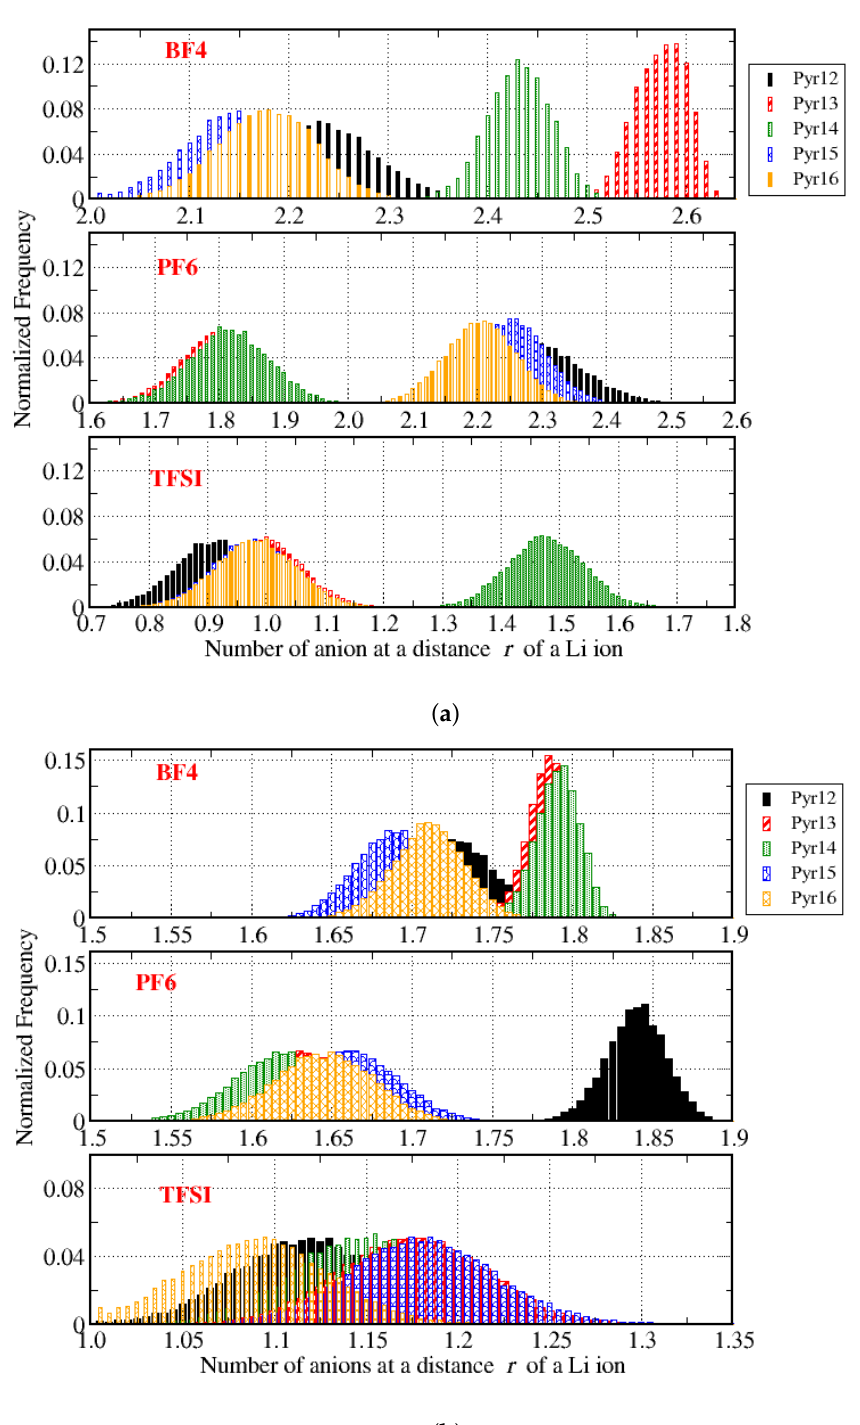
Figure 12. Histograms of the number of anions around the Li-ions throughout the trajectories, for all systems. In ( a ) with 0.25 Li and in ( b ) with 0.50